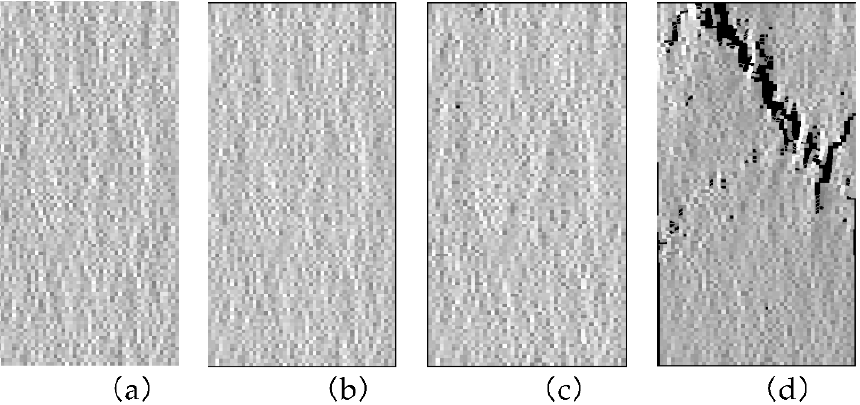
Figure 9. Deformation and rupture of coal samples when the gas pressure is 0.5 MPa: ( a ) the loading step is 17; ( b ) the loading step is 28; ( c ) the loading step is 49; ( d ) the loading step is 65.